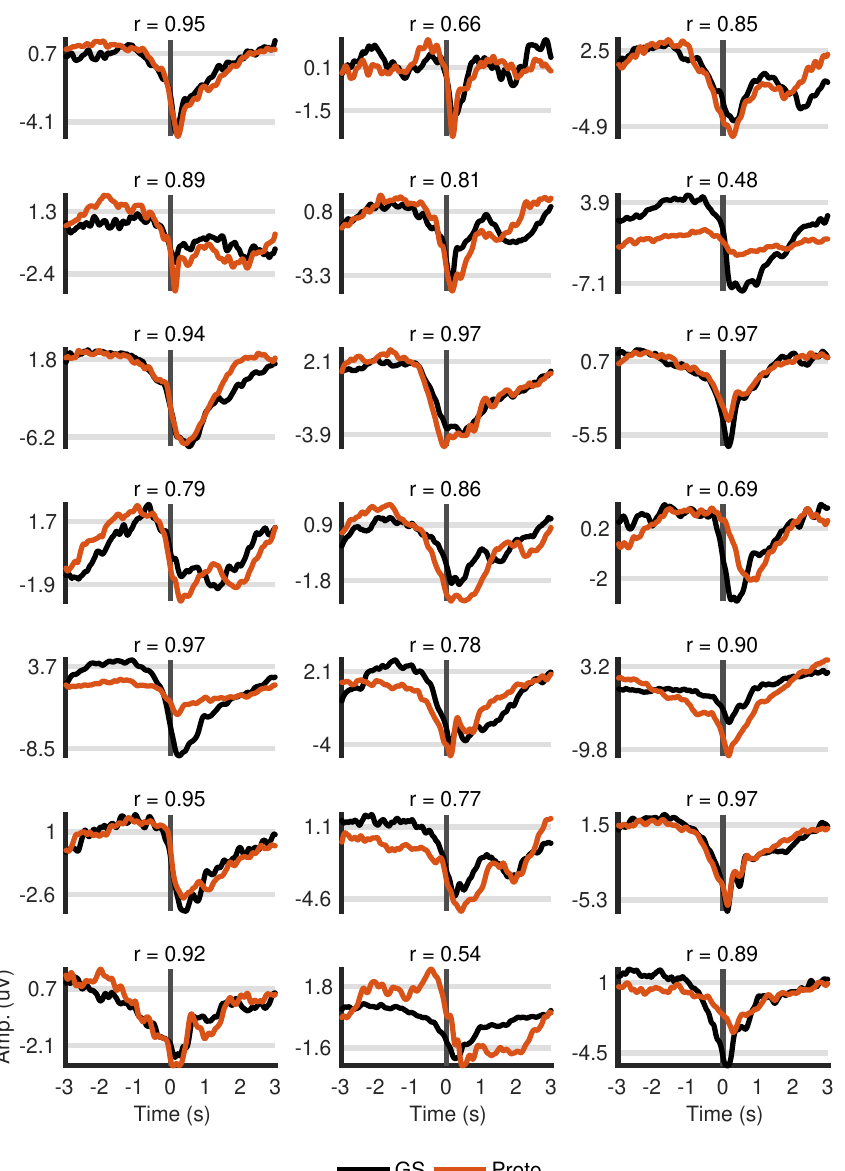
Figure A1. Averaged MRCPs for 21 participants in dorsiflexion from gold standard and the prototype along with cosine similarity (r). GS and Proto stand for the gold standard and the prototype system